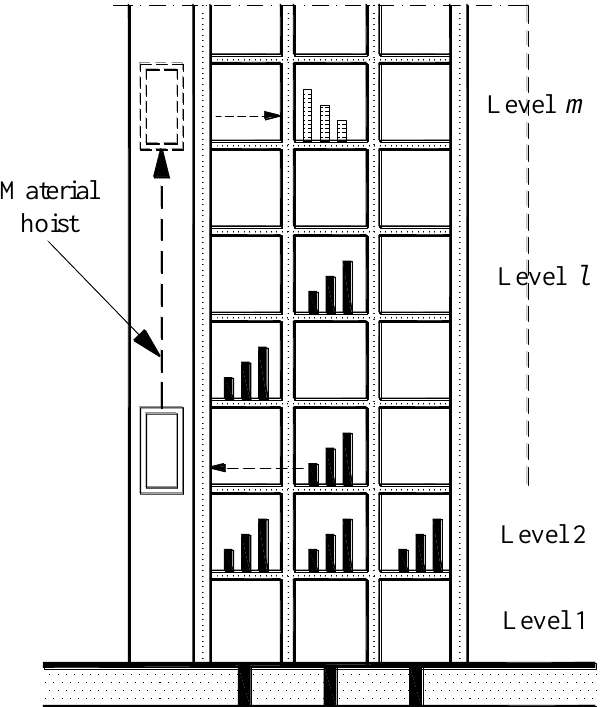
Figure 5. Side view of the material hoist in multi-storey building construction. Algorithms 2020 , 13 , 117